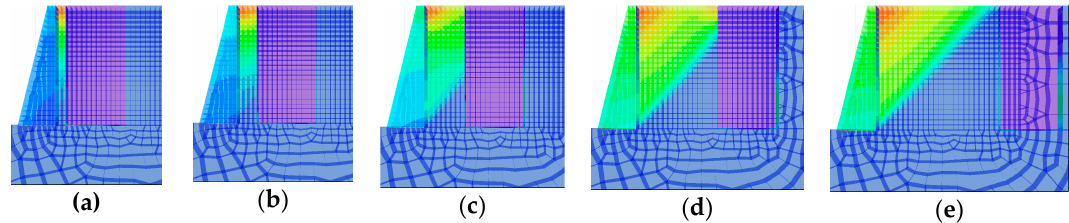
Figure 9. Displacement cloud map for c - ϕ soil (cohesive soil) of limited width of ( a ) 1 m; ( b ) 2 m; ( c ) 4 m; ( d ) 6 m; and ( e ) 8 m.